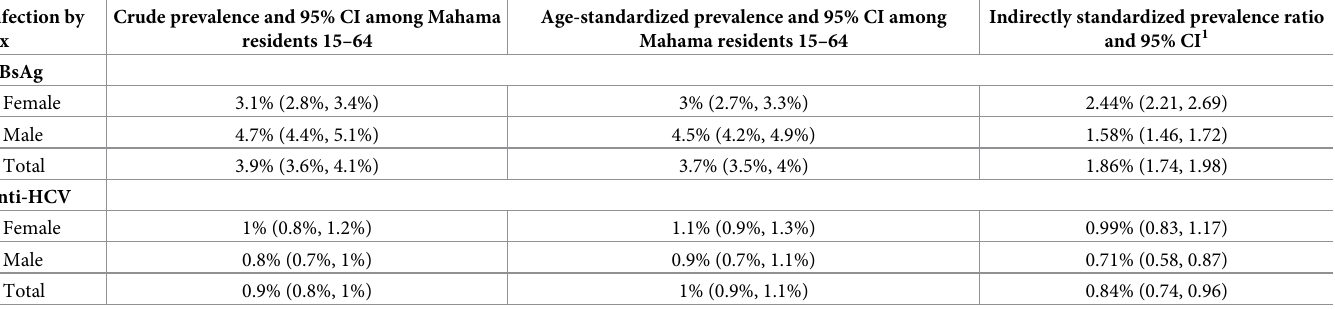
Table 3. Prevalence of HBsAg and anti-HCV among Mahama residents aged 15–64 compared to age-standardized prevalence in the general population. Infection by